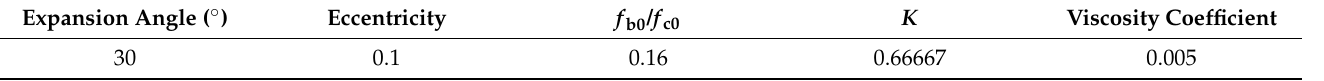
Figure 6. Plastic damage factor of concrete.